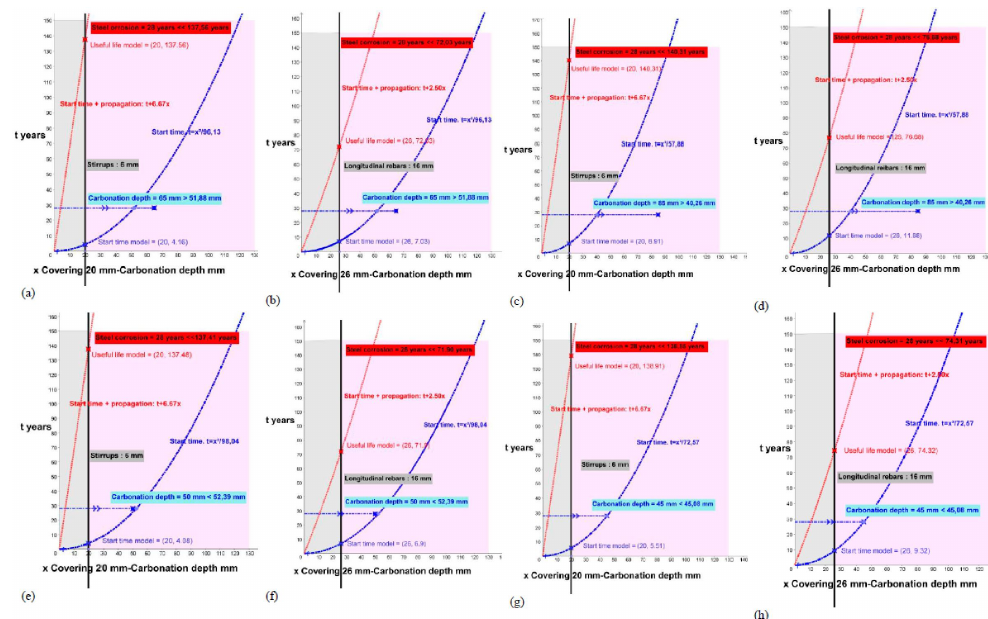
Figure 9. Start and propagation corrosion times in building 6D and 7R. ( a ) 6D_P1_ Stirrups. ( b ) 6D_P1_ longitudinal rebars. ( c ) 6D_P5_ Stirrups. ( d ) 6D_P5_ longitudinal rebars. ( e ) 7R_P1_ Stirrups.